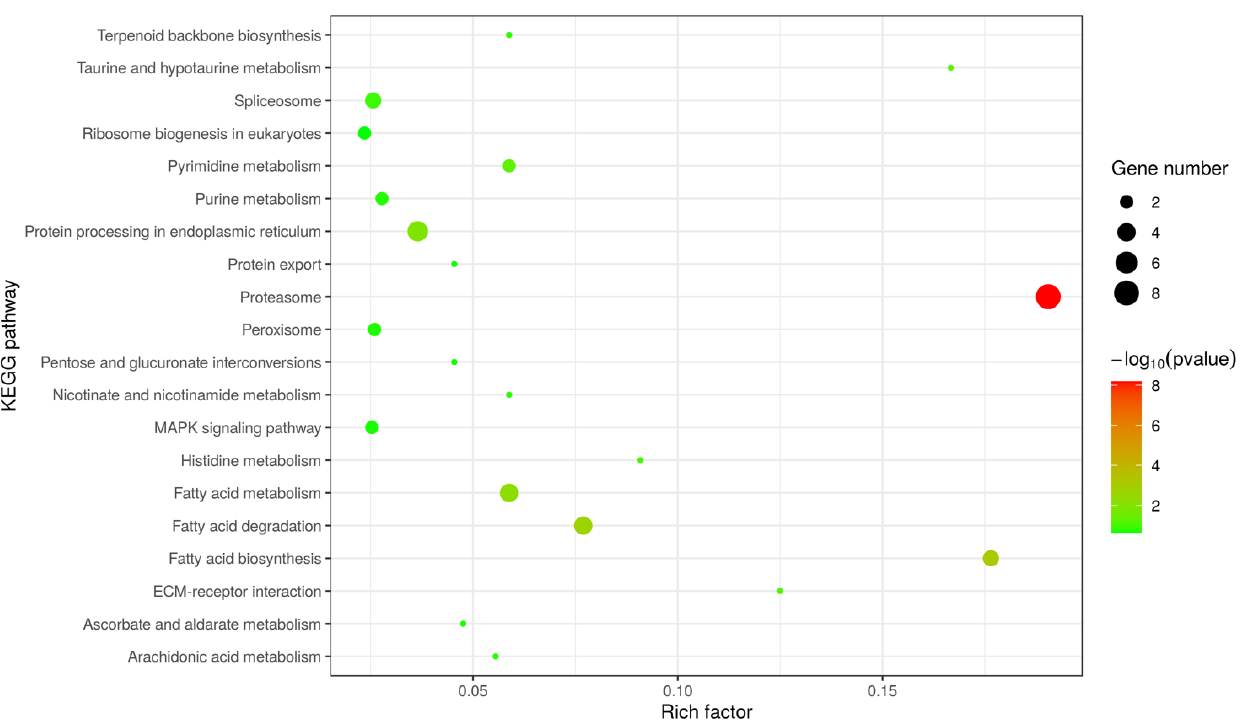
Figure 5. Top 20 KEGG pathways enriched from 130 surface proteins. Twenty KEGG pathways were obviously enriched from surface proteins of EHP spores ( p - value of Fisher’s exact test < 0.01). MAPK: the mitogen-activated protein kinase; ECM-receptor: the extracellular matrix receptor. pvalue: p -value. Table 2. Profile of 15 high-abundance surface proteins of Enterocytozoon hepatopenaei spores. Length Protein ID Annotation ( Aa )